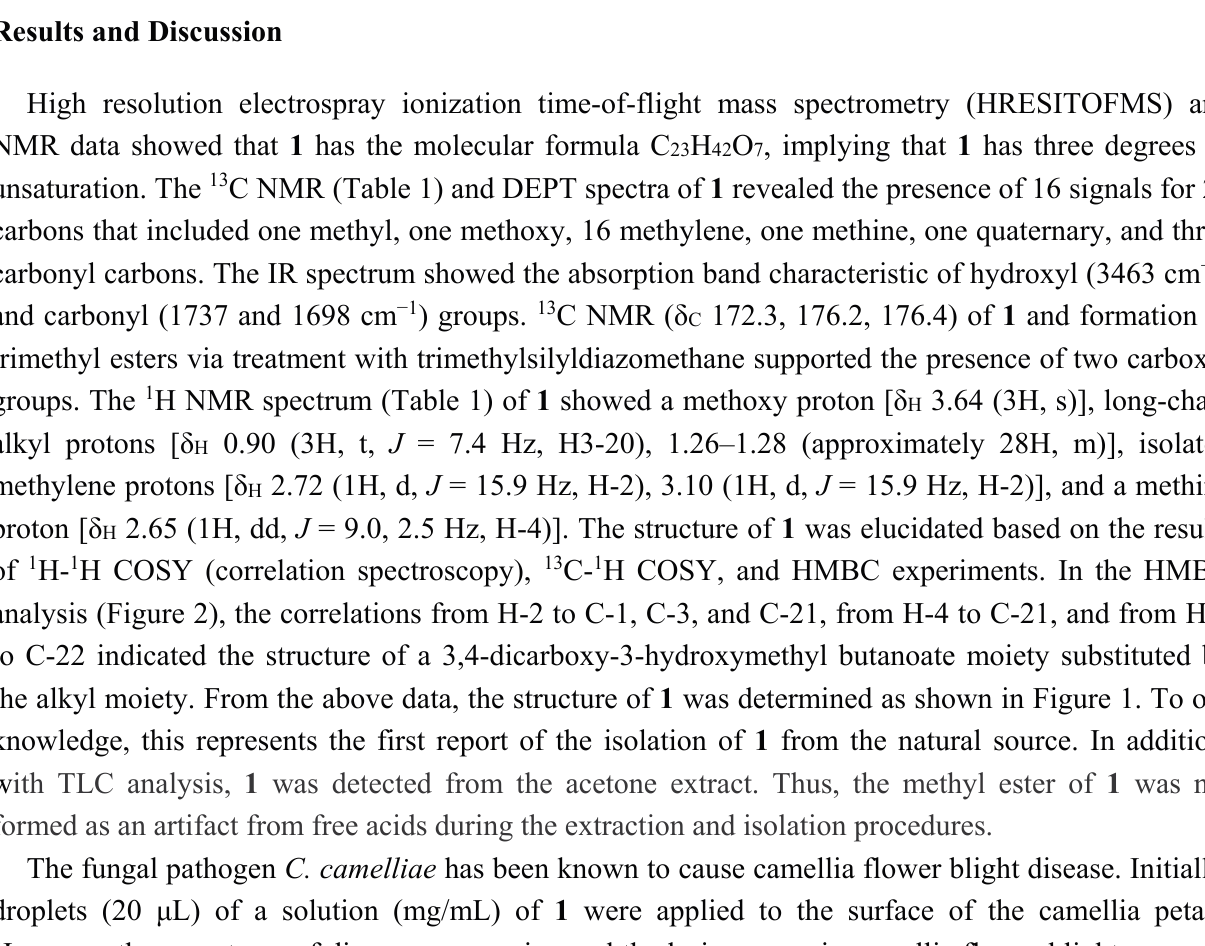
Figure 1. Structure of 1